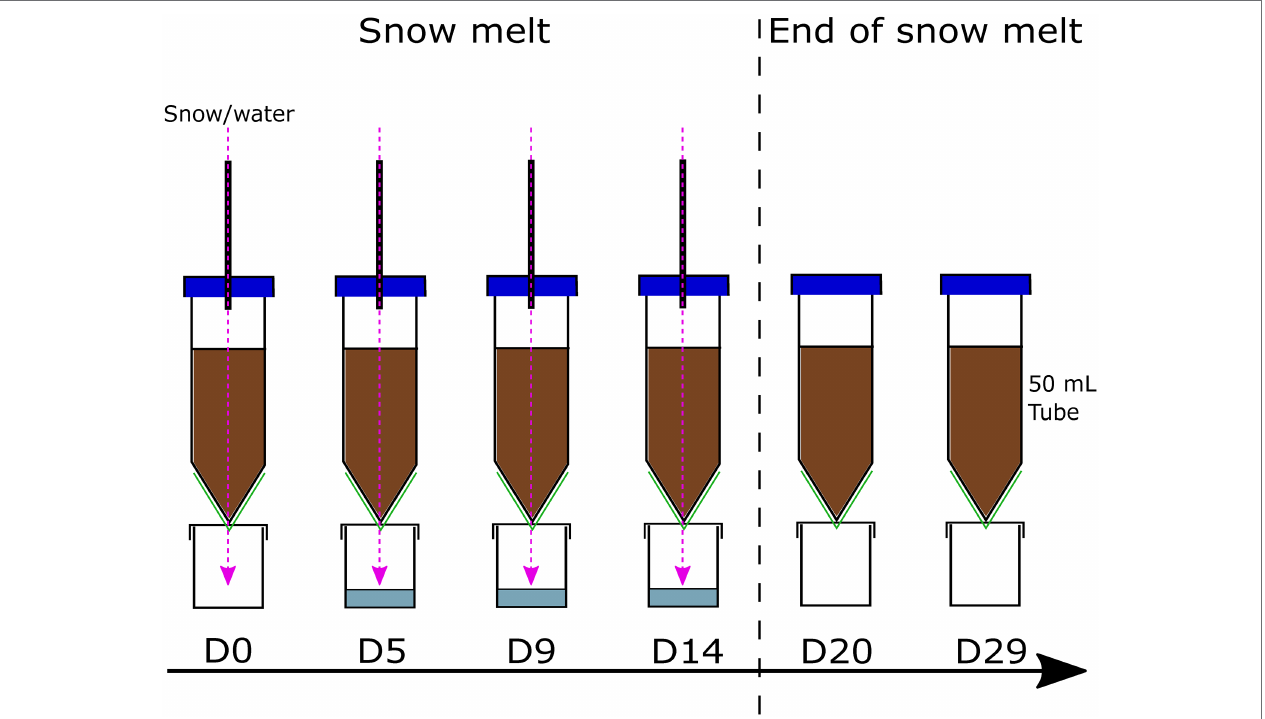
FIGURE 1 | Microcosm construction. The snow/sterile water was input using a programmable peristaltic dosing pump, through a hole in the centrifugal tube cap. To allow infiltration and evacuation of the excess liquid, a hole was made at the bottom of the tube, covered with a membrane (green) allowing the easy passage of liquid and cells while retaining the soil in the microcosm system. Snow/sterile water was input every day for 14 days and stopped thereafter; the hole in the centrifugal tube cap was covered with autoclaved aluminium to avoid contamination from outside the